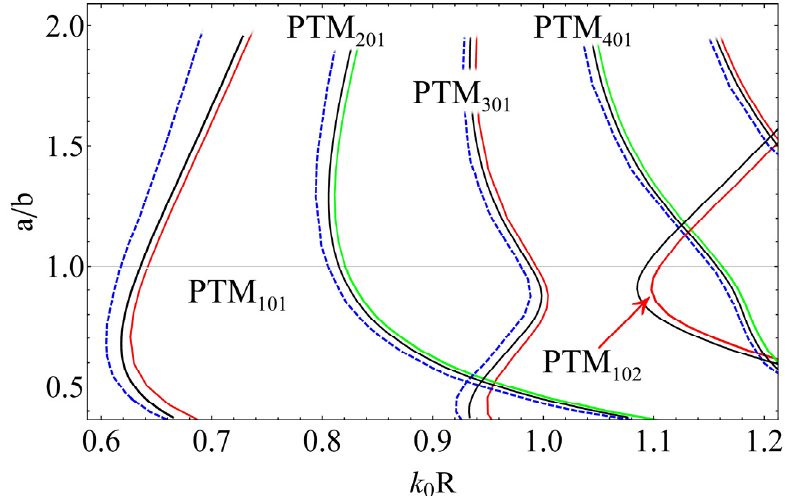
Figure 6. Perfect nonradiating TM modes (PTM) of spheroids with ε = 50 (Bi 2 Te 3 ) as a function of the size parameter k 0 R and the spheroid aspect ratio, a/b . Red and green curves stand for odd and even perfect nonradiating modes, blue dashed lines correspond to usual quasinormal modes. Black curves show the frequencies of confined modes (18), ω n , confined = k 0 n c .